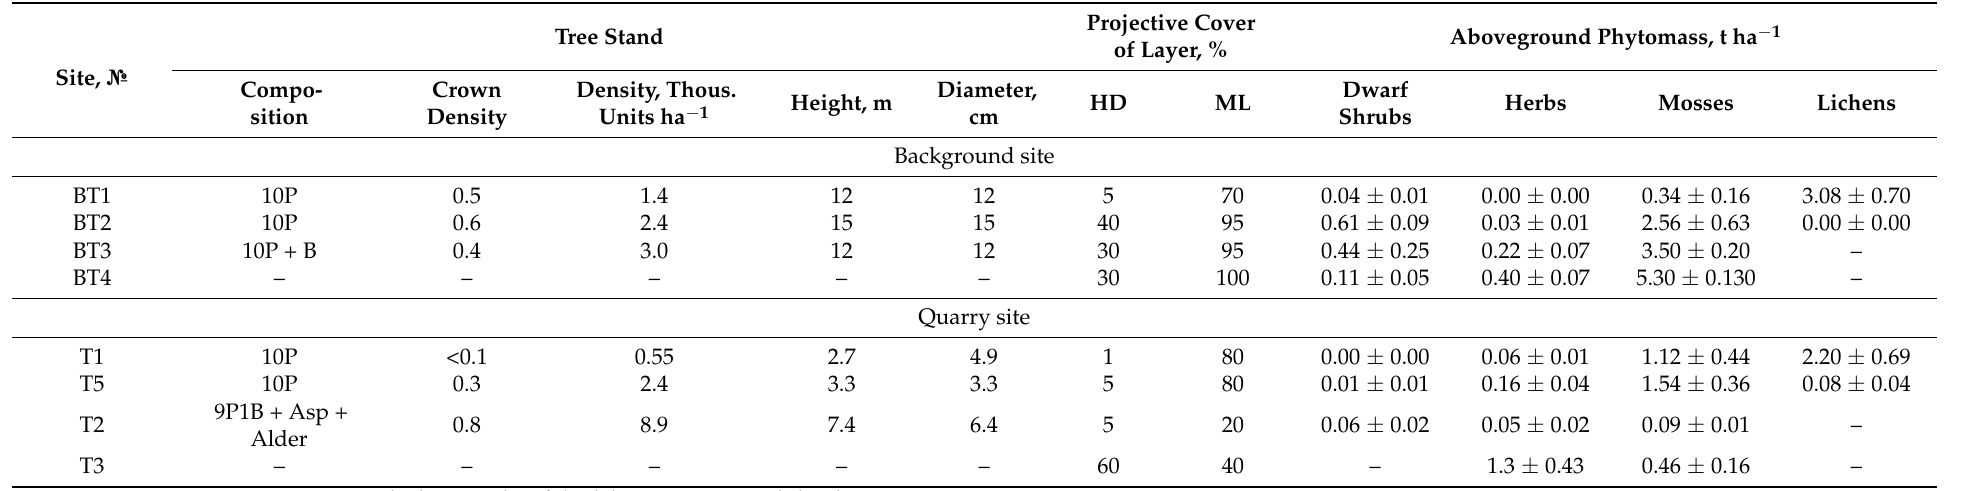
HD—herbaceous-dwarf shrub layer, ML—mossy-lichen